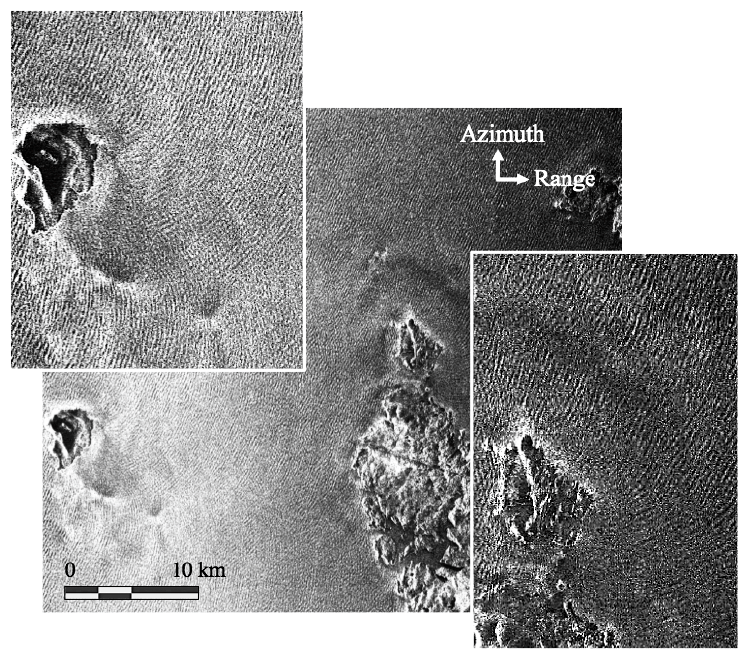
Figure 2. SEASAT–SAR image of the North Sea in northern Scotland, where the island of Foula is on the left and the mainland on the right. The images of ocean waves can be seen propagating from left to right in the range direction, and those refracted around the islands in the enlarged images.